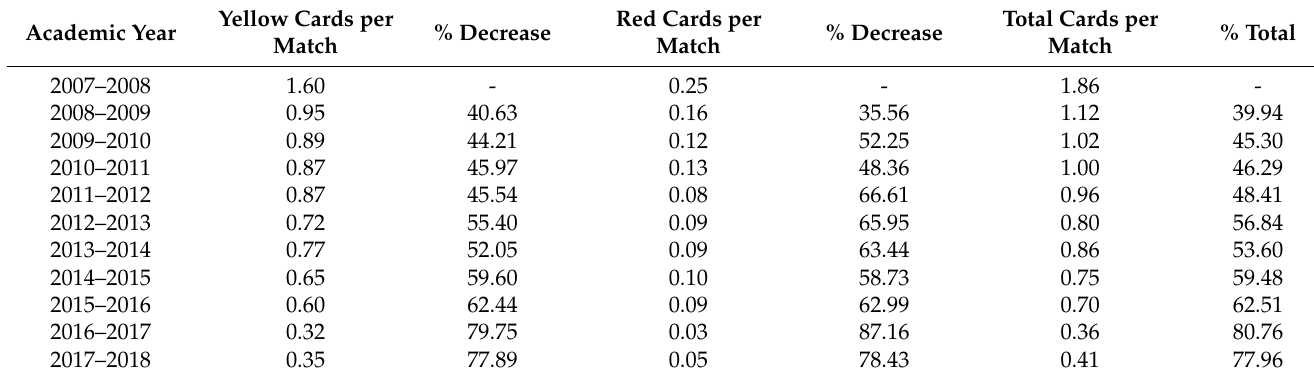
Table 4. Evolution of the average number of cards shown per match in the ten academic years analyzed, and percentage decrease compared to the previous